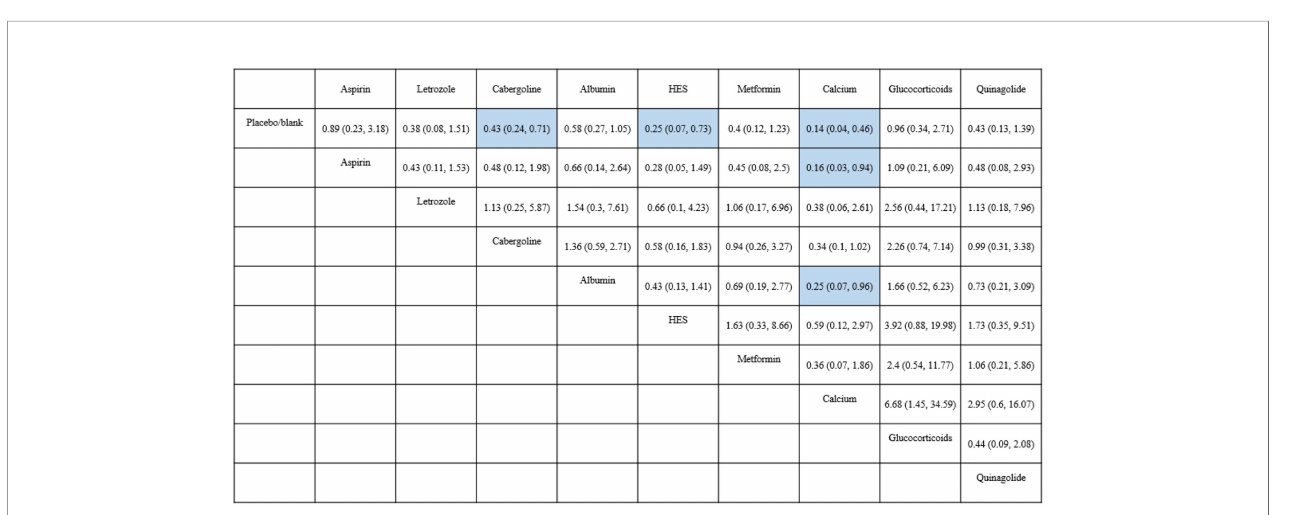
FIGURE 4 | Results of network meta-analysis for moderate-to-severe OHSS. Results are shown as RR (95%CI), representing column-de fi ning treatment versus row-de fi ning treatment. HES, Hydroxyethyl starch. Statistically signi fi cant results are shown in